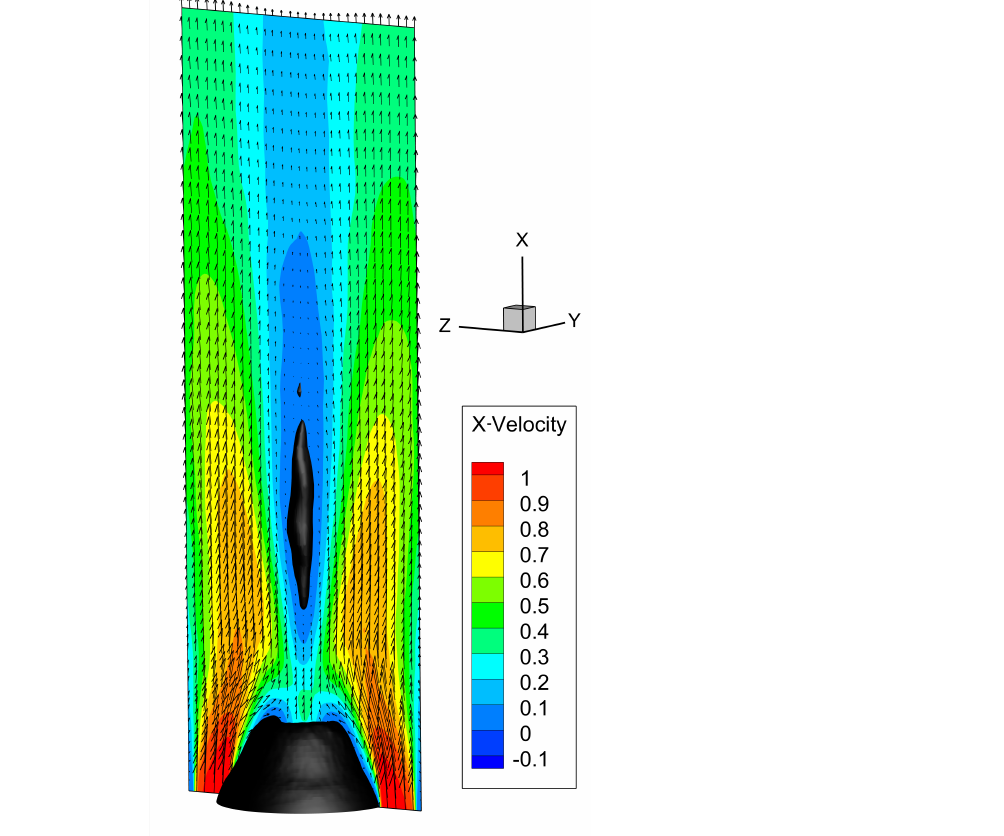
Figure 1. The time-averaged flow field of an annular jet. The x -direction is the direction of the jet flow.